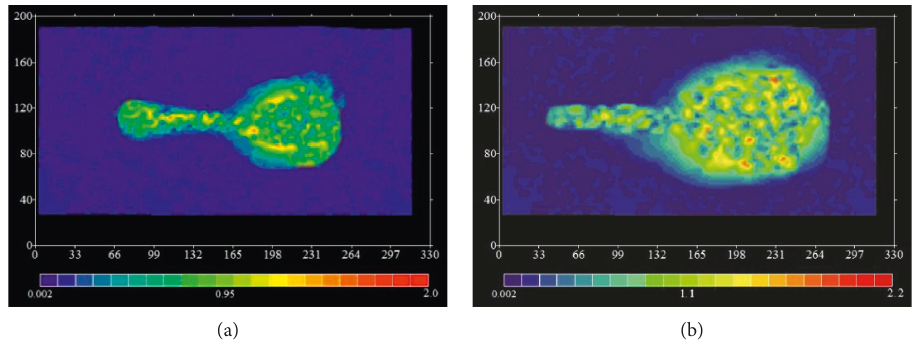
Figure 8: Soil displacement of with different anchor plate diameters. (a) D � 3cm. (b) D � 5cm.